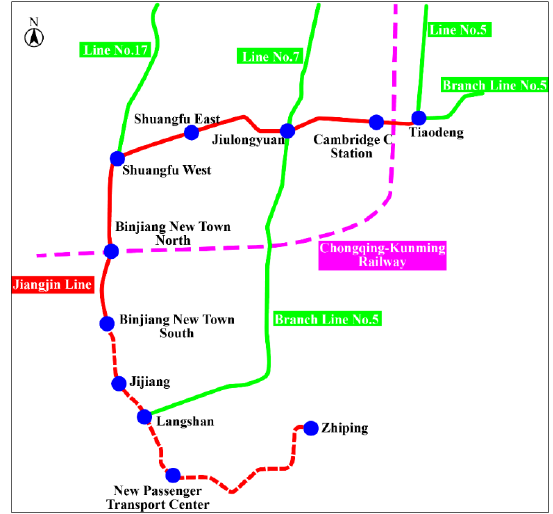
Figure 5. Map of the Jiangjin Line.